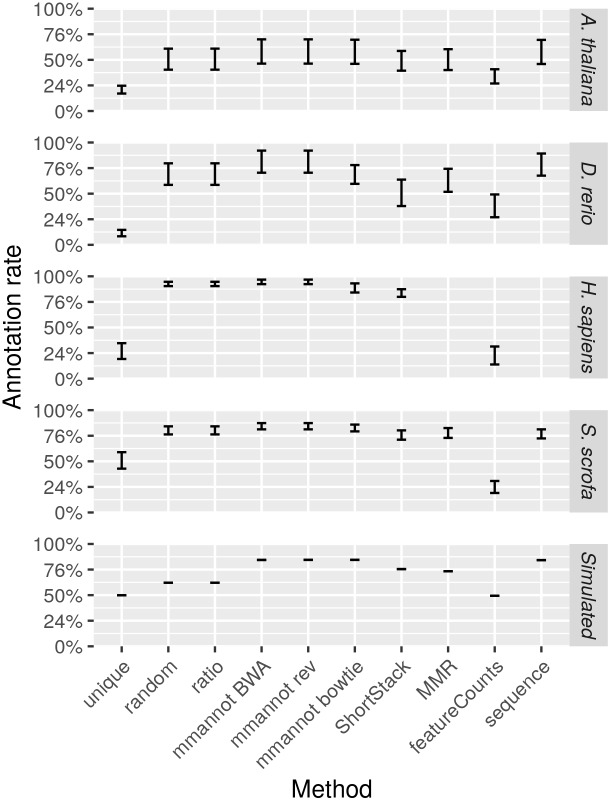
Actual annotation rates of the methods.The actual annotation rate is the number of reads used for the annotation, divided by the number of reads sequenced. The bars give the minimum and the maximum annotation rates for each method.